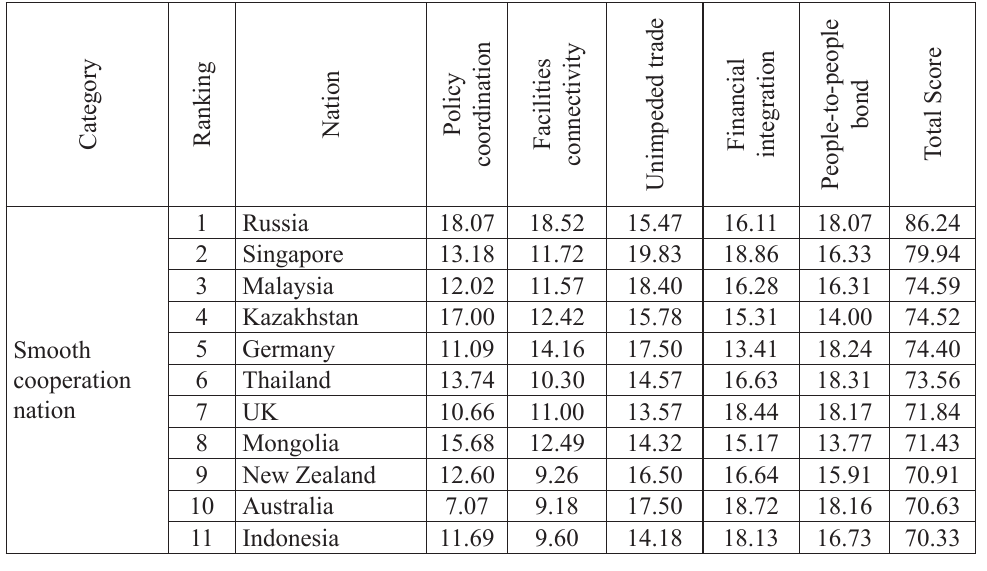
Table 1: Rankings and Scores of Nations along the Belt and Road in terms of Five Connectivity (Table